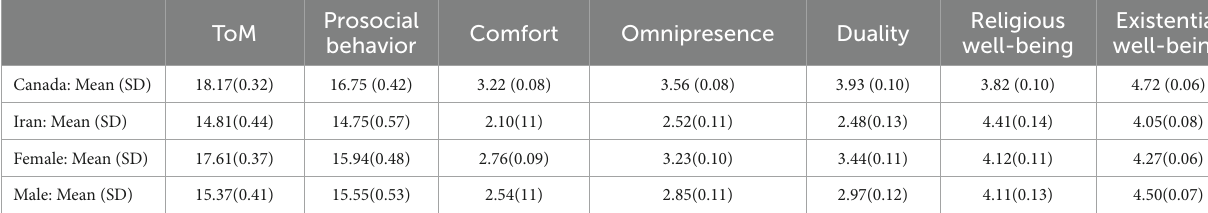
TABLE 2 Descriptive statistics of subgroups divided by culture &